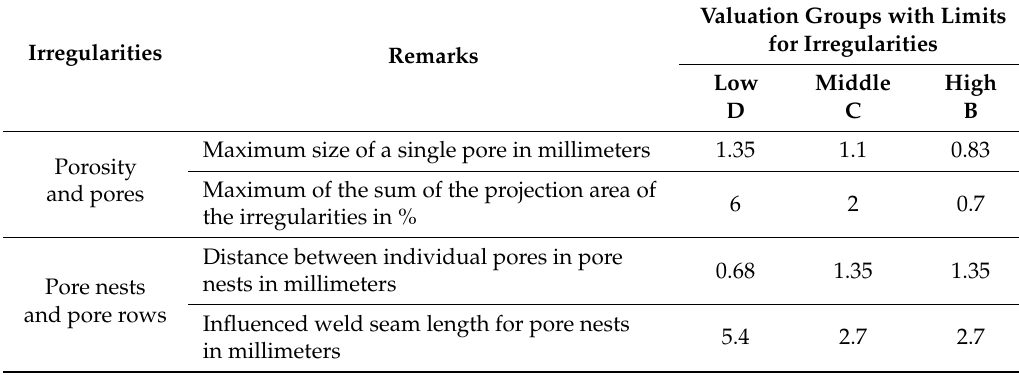
Table 4. Valuation groups in accordance to DIN EN ISO 13919-1 for material thickness 2.7 mm